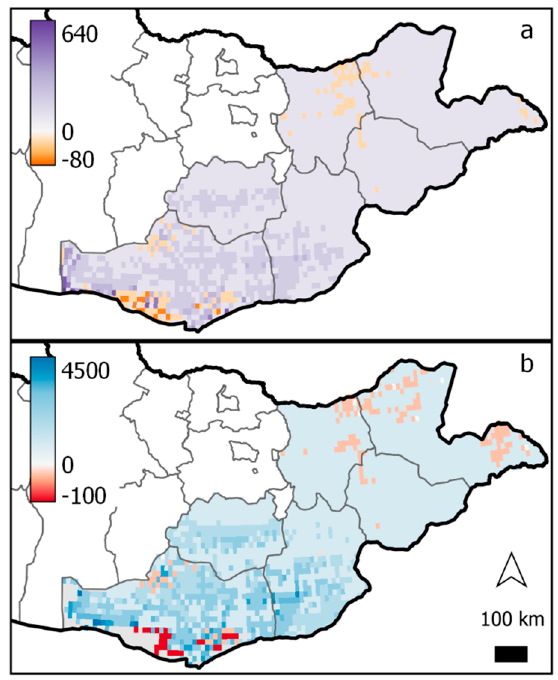
Figure 5. Percent change in mean standing biomass (panel ( a ), top) and mean animal diet sufficiency (panel ( b ), bottom) when driving RPM with future climate conditions and current livestock densities, versus current conditions. Negative values indicate a decrease in biomass or diet sufficiency under future climate conditions; positive values indicate an increase.